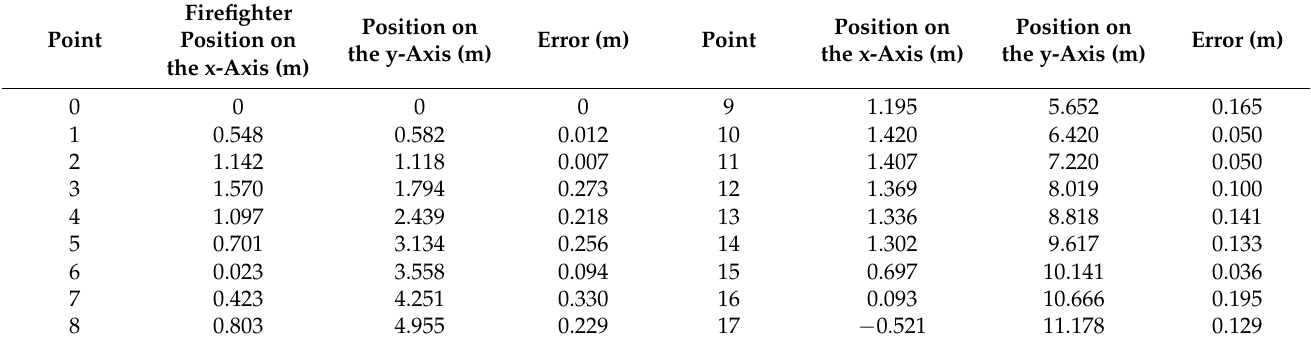
Table 7. The position of the point in the map followed the Beacons to the fire